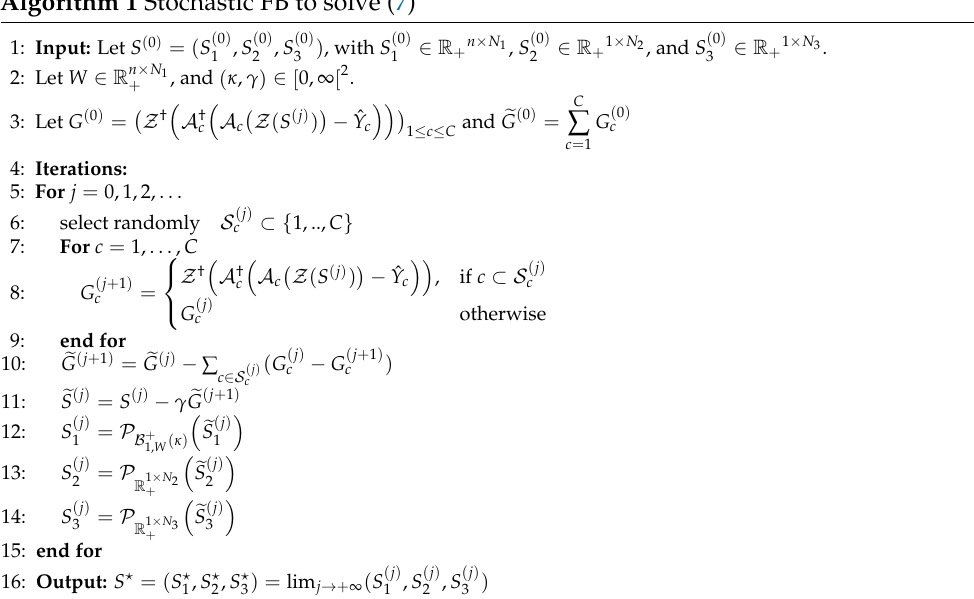
Algorithm 1 Stochastic FB to solve